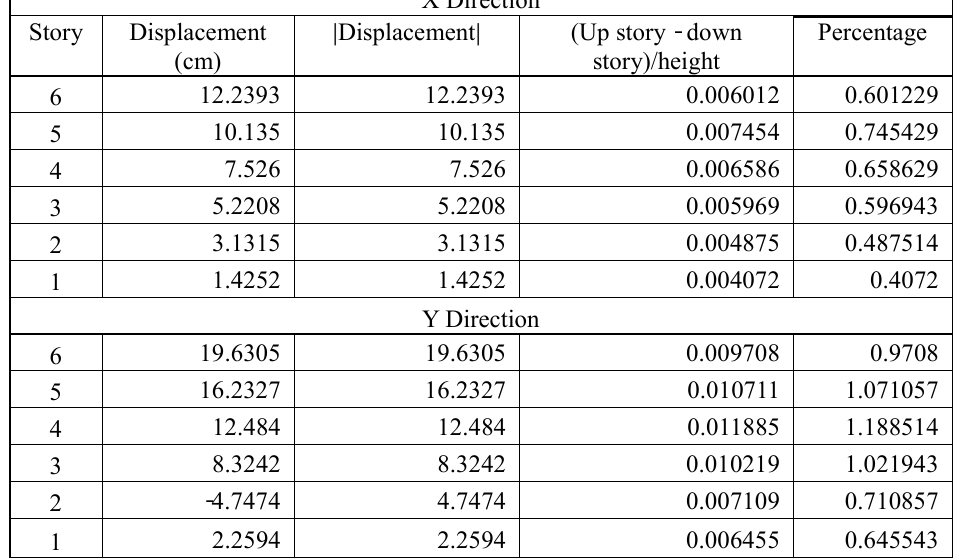
The results of 6-story structure under Northridge earthquake record in U2 direction.